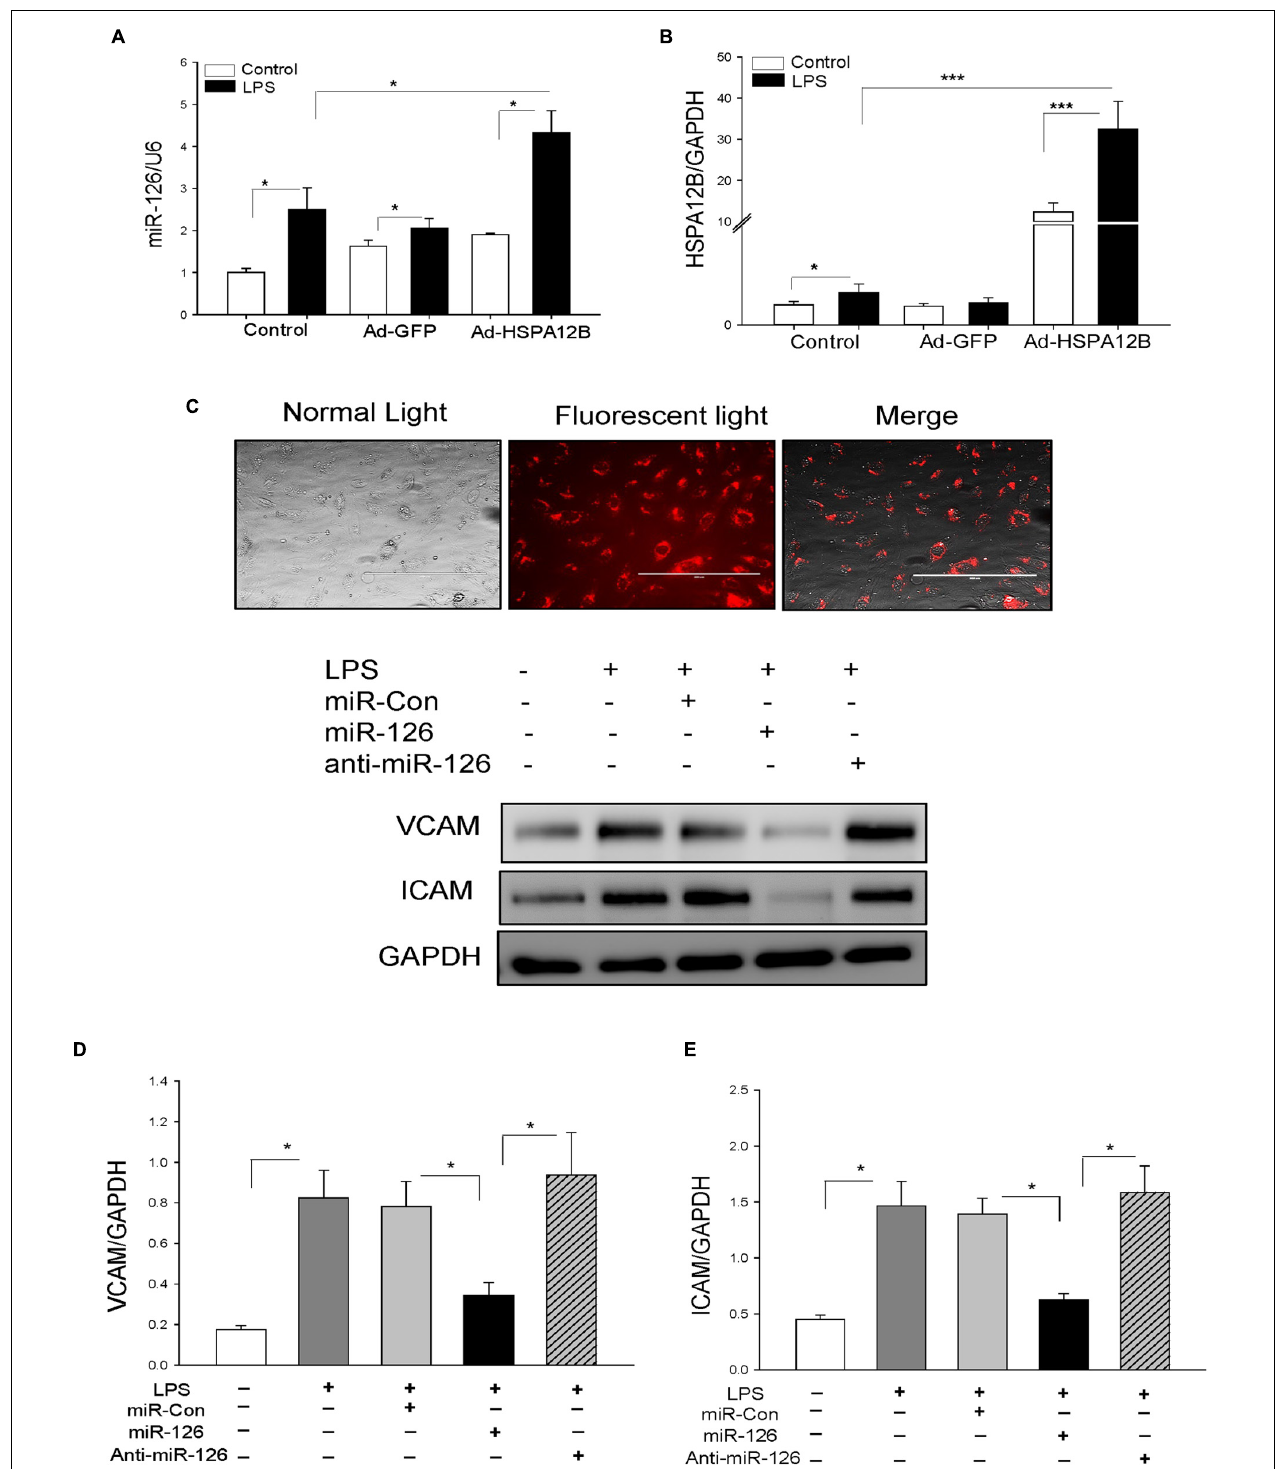
FIGURE 4 | Transfection of endothelial cells with miR-126 mimics prevented LPS-induced expression of adhesion molecule expression. Endothelial cells (HUVECs) were transfected with 40 nmol of microRNAs (scrambled miR-control, miR-126 mimics, or anti–miR-126) by Lipofectamine 2000. Twenty-four hours after transfection, the cells were treated with LPS (1 µ g/mL) for 6 h. (A) miR-126 levels and (B) HSPA12B expression. (C) Transfection of miR-126 mimics (red color) into endothelial cells. Transfection of miR-126 mimics suppresses LPS-induced expression of VCAM-1 (D) and ICAM1 (E) in endothelial cells. n = 3–4/group. * P < 0.05 compared with indicated